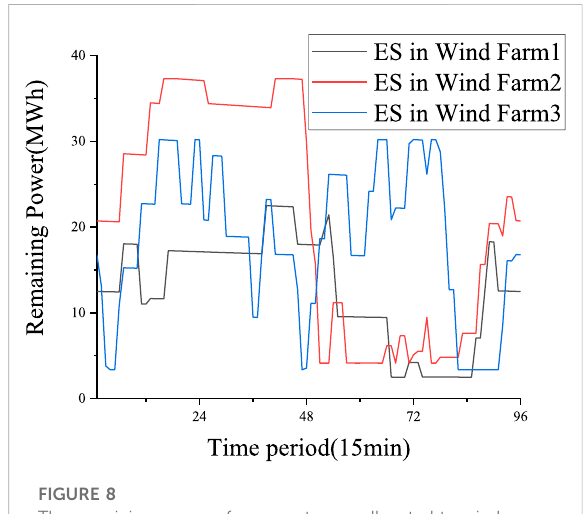
FIGURE 7 Over-limit power export.